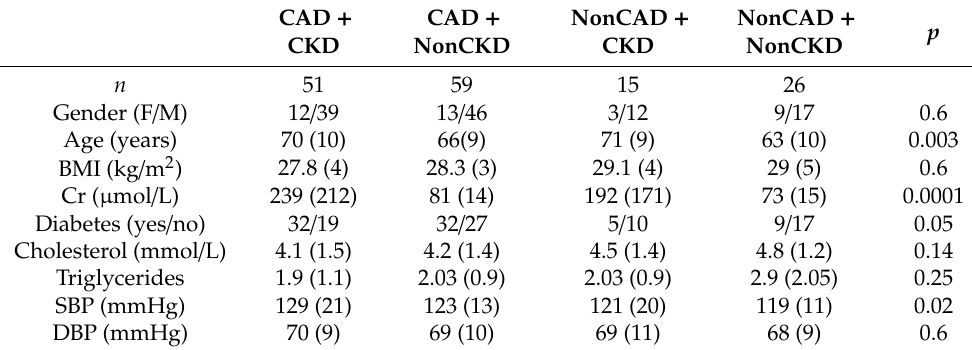
Table 1. Baseline clinical characteristics of